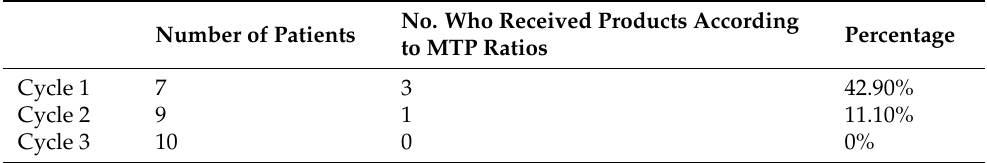
Table 4. Number of patients who received blood products in the predefined MTP ratios according to the cycle